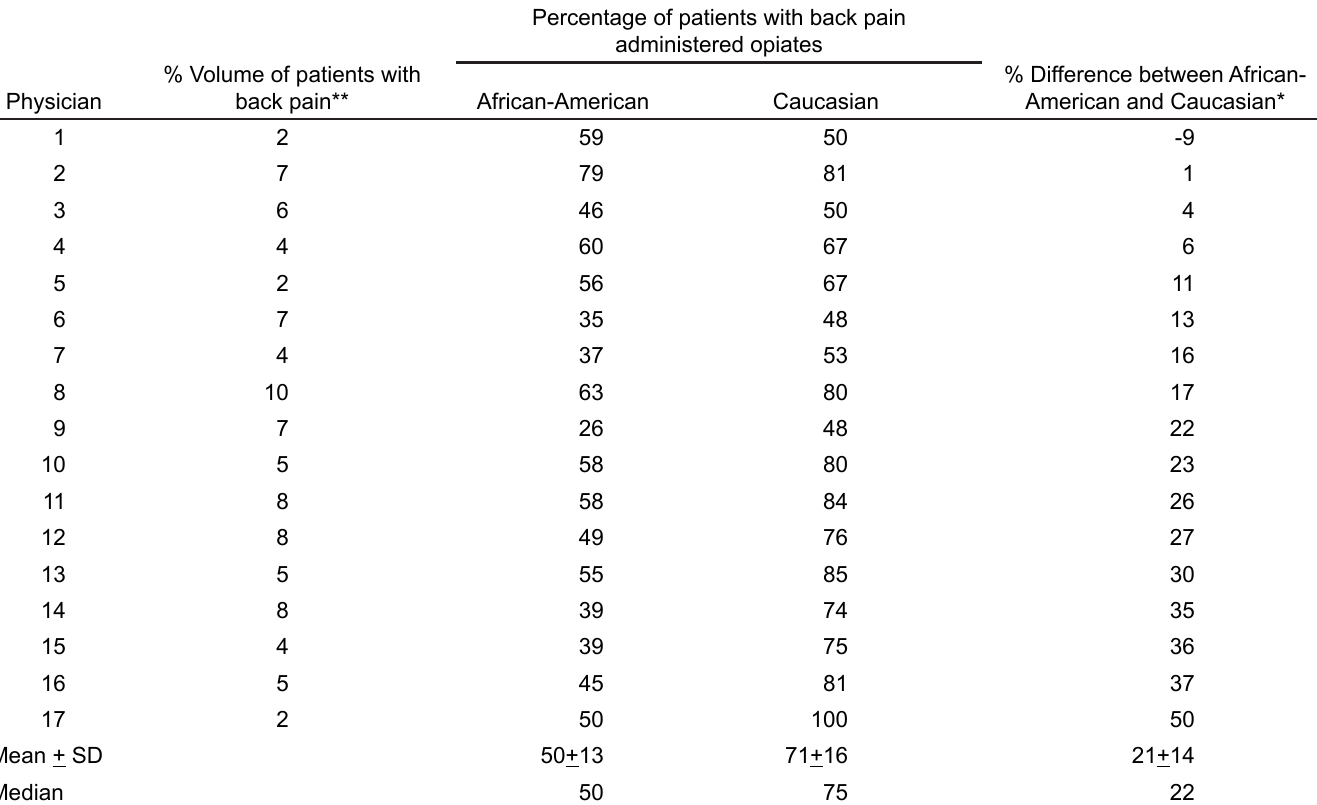
Table 5. Treating practices of physicians who had seen 25 or more patients with back pain.